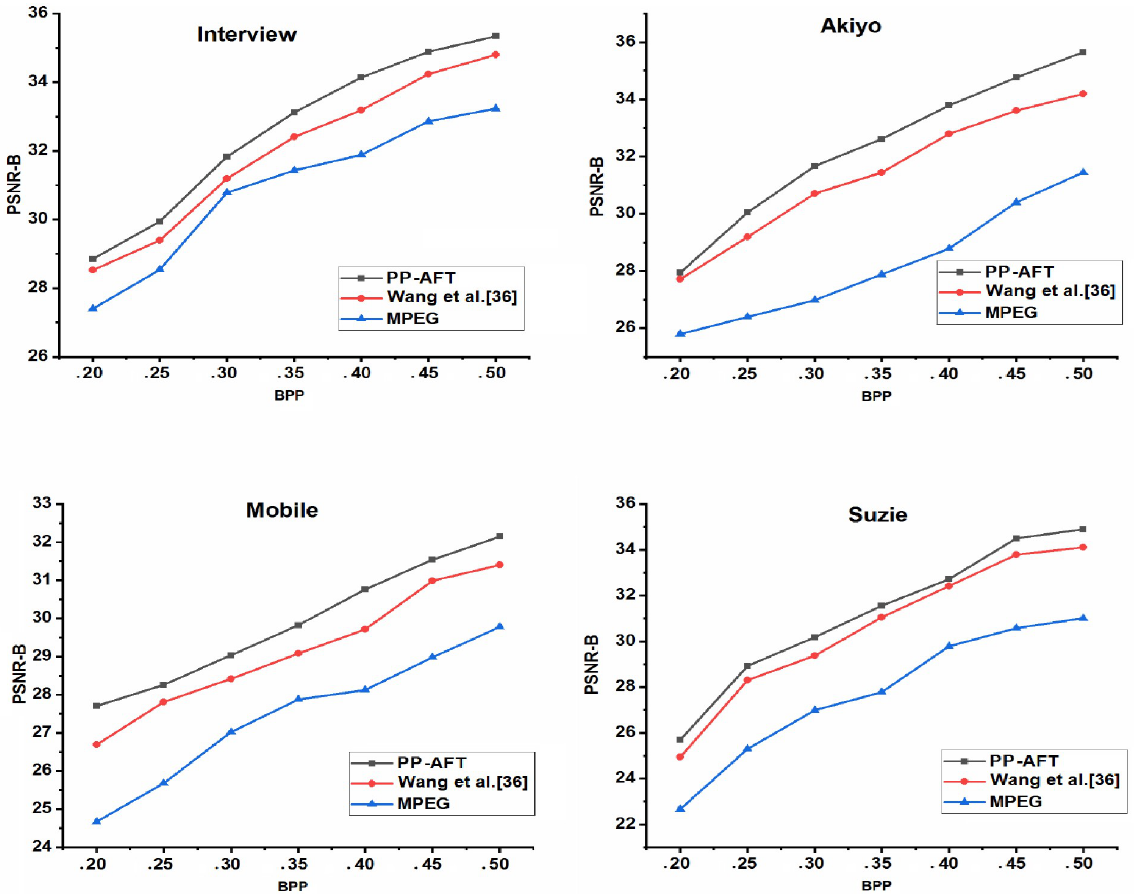
Fig 7. Objective analysis of different video frames sequence PSNR-B vs QP for (a) Interview, (b) Akiyo, (c) Mobile and (d) Suzie.